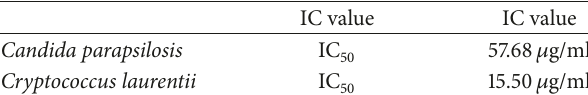
Table 2: IC 50 Amphotericin